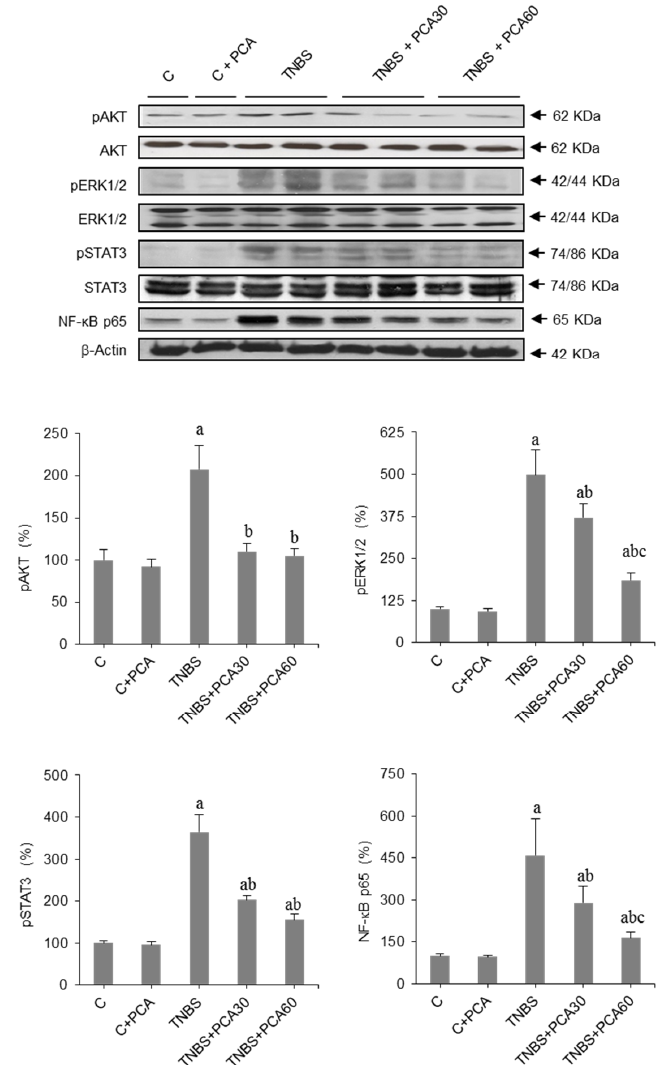
Figure 5. Effect of treatment with protocatechuic acid (PCA) on AKT, ERK, STAT and NF ‐κ B expression in mice with 2,4,6 ‐ trinitrobenzenesulfonic acid (TNBS) ‐ induced colitis. Representative blots for pAKT, AKT, pERK1/2, ERK, pSTAT3, STAT3 and NF ‐κ B p65 proteins, and results of densitometric quantification. Values are expressed as the means ± SEM of six mice per group. a p < 0.05 vs. C group; b p < 0.05 vs. TNBS group; c p < 0.05 vs. TNBS + PCA30 group. Each assay was performed in triplicate.